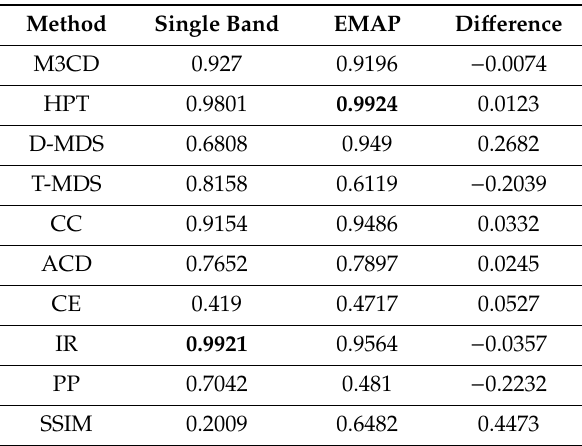
Figure 4. ROC curves for Image Pair-1 (SAR / SPOT) with EMAP. Table 2. Area under curve ( AUC) values and differences between single band and EMAP cases for dataset-1. Bold numbers indicate the best performing method in each column. M3CD: Markov Model for Multimodal Change Detection; HPT: Homogeneous Pixel Transformation; D-MDS: Direct approach; T-MDS: Single band approach; CC: Chronochrome; CE: Covariance Equalization; ACD: Anomalous Change Detection; IR: Image Ratioing; PP: Pixel Pair; SSIM Structural Similarity.